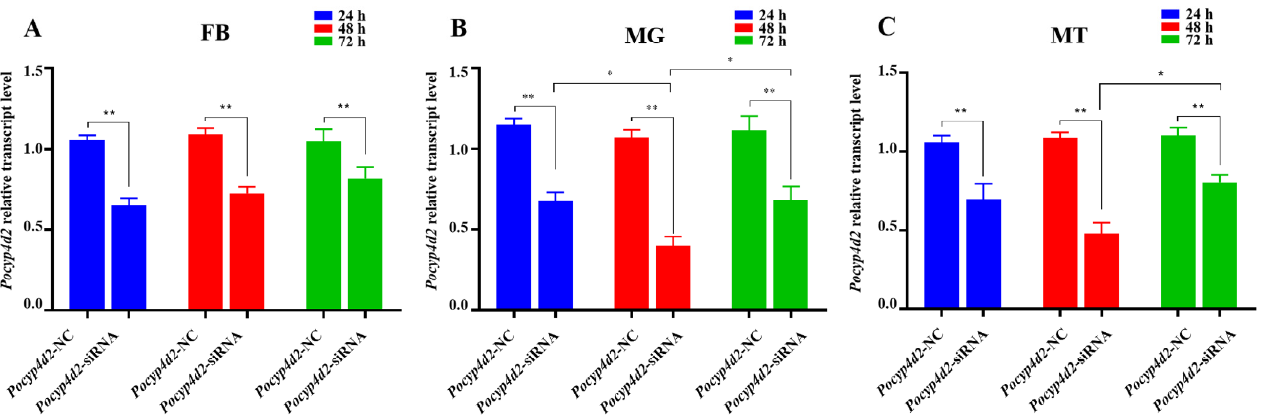
Figure 5. Changes in Pocyp4d2 relative expression in different tissues of P. okadai after Pocyp4d2- siRNA interference as detected by RT-qPCR ( X(cid:3365) ± s, n = 3). Effects of Pocyp4d2 knockdown in the ( A )